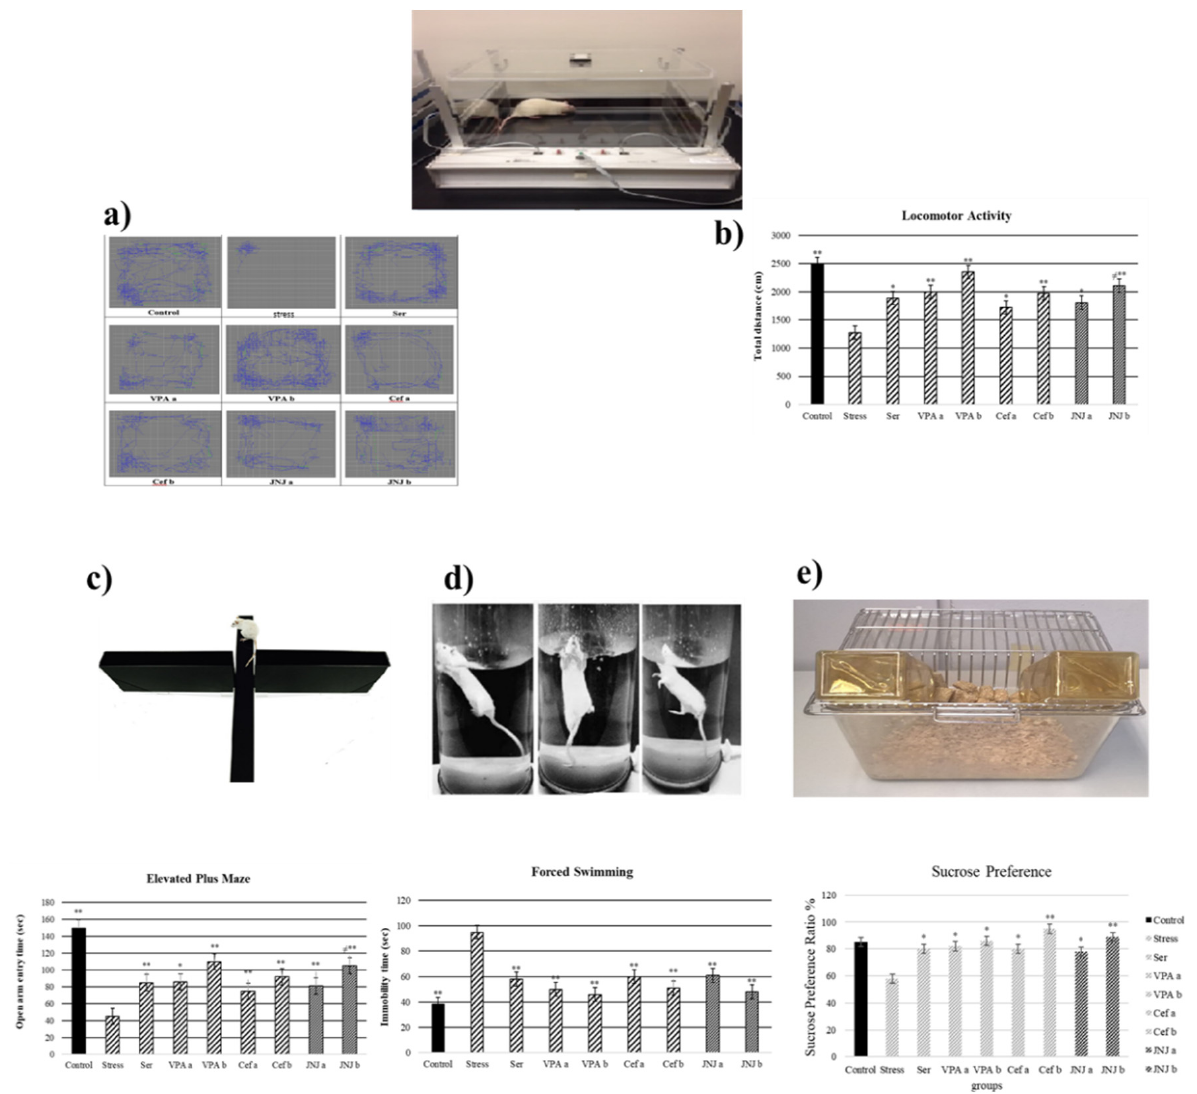
Figure 3. Behavioral performances of experimental groups exposed to stress 30 days after treatment. Locomotor activity: ( a ) schematic of travel area. ( b ) distance traveled. ( c ) Elevated plus-maze test: open arm entry time (s). ( d ) Forced swimming: immobility time (s). ( e ) Sucrose preference amount consumption (%). One-way ANOVA, * p < 0.05, ** p < 0.001 compared with the Stress group.; ≠ p < 0.05 compared with JNJa.